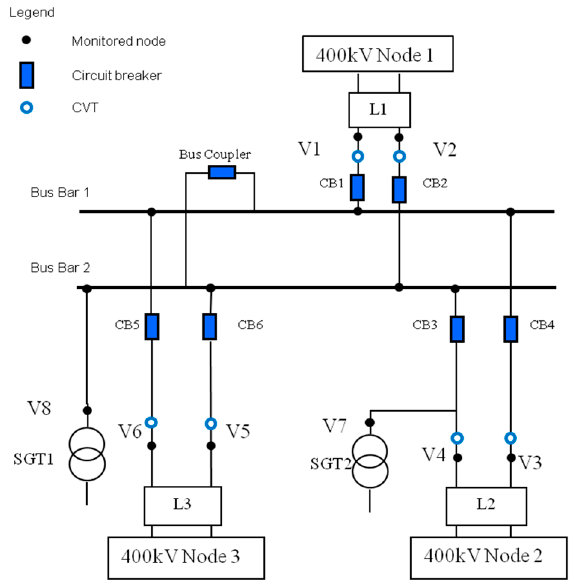
Figure 7. Single line diagram of a double busbar substation (400/132 kV). V1 to V8 nodes indicating the possible location of the SA installation.